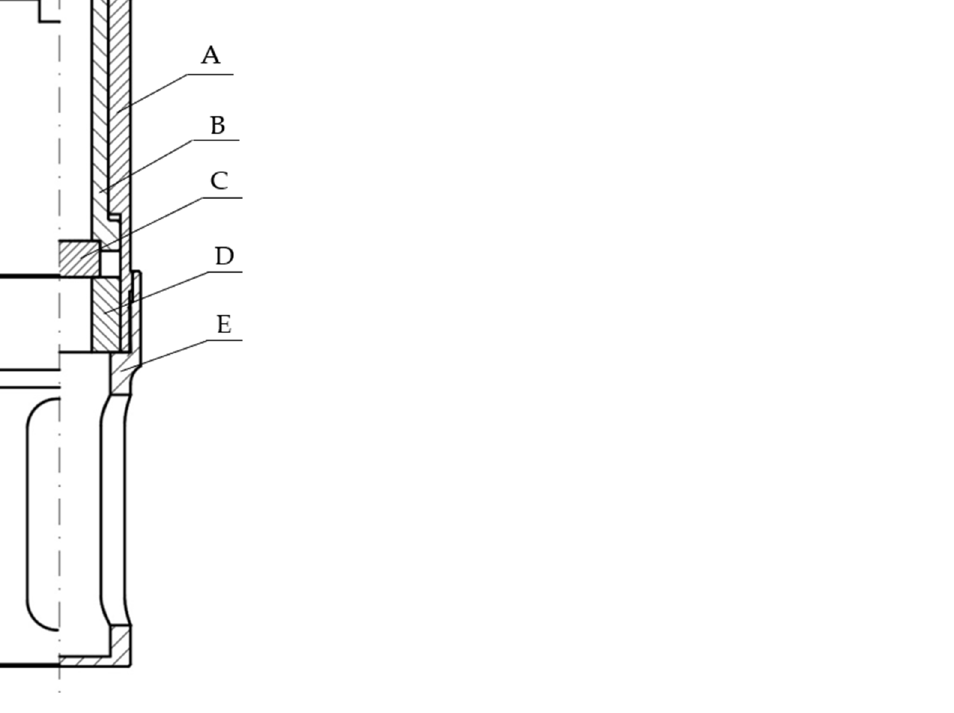
Figure 4. Compacting sleeve assembly, cross-section view: A. Upper sleeve, B. Compacting chamber, C. Compacting chamber bottom, D. Spacer sleeve, E. Lower sleeve [21].